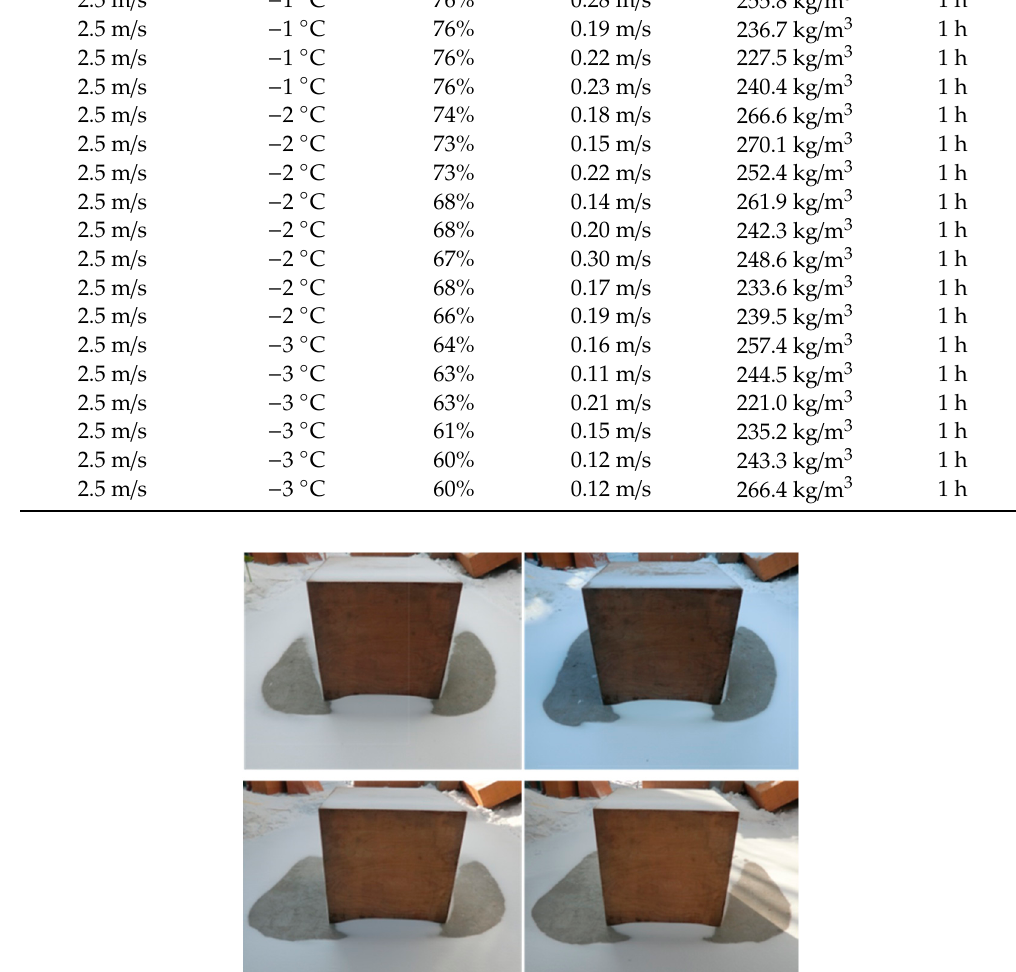
Figure 7. Some photos of the repetitive experiments.